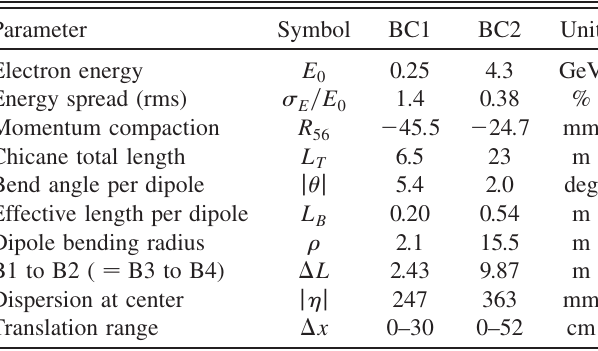
TABLE II. BC1 and BC2 chicane parameters at 250 pC.